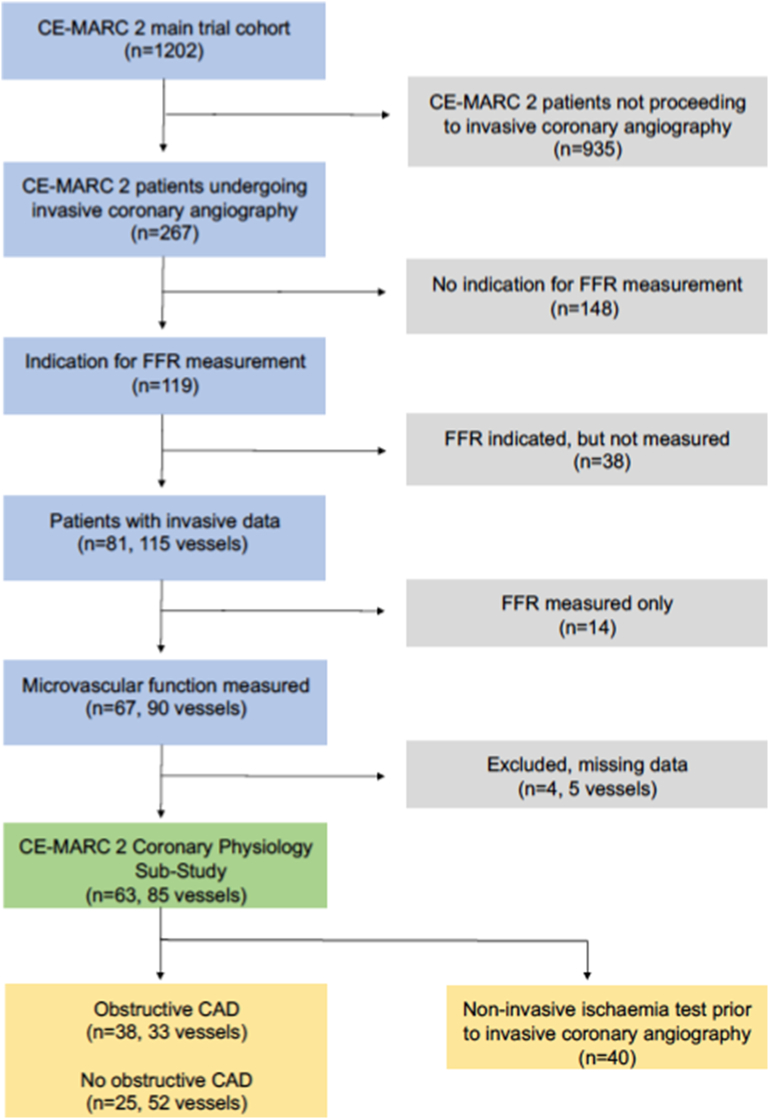
CONSORT flow diagram.CONSORT flow diagram of patients enrolled in the CE-MARC 2 microvascular sub-study. Of 1202 patients enrolled into the CE-MARC 2 trial, 267 (22.2%) underwent invasive coronary angiography and 119 (45%) of these patients had an indication for FFR measurement. Thirty-eight (32%) of these patients did not have FFR measured for the following reasons: severe obstructive CAD, n = 15; urgent invasive management, n = 3; clinical and technical factors, n = 20. Eighty-one patients had FFR measured in at least one coronary artery (115 vessels) and additional parameters of microvascular function were available for 63/81 (78%) patients in 85 vessels. Overall, 63 patients had coronary microvascular function assessed, including 22, 18 and 23 patients randomised to CMR-guided, MPS-guided and NICE management-guided care, respectively.FFR = fractional flow reserve.